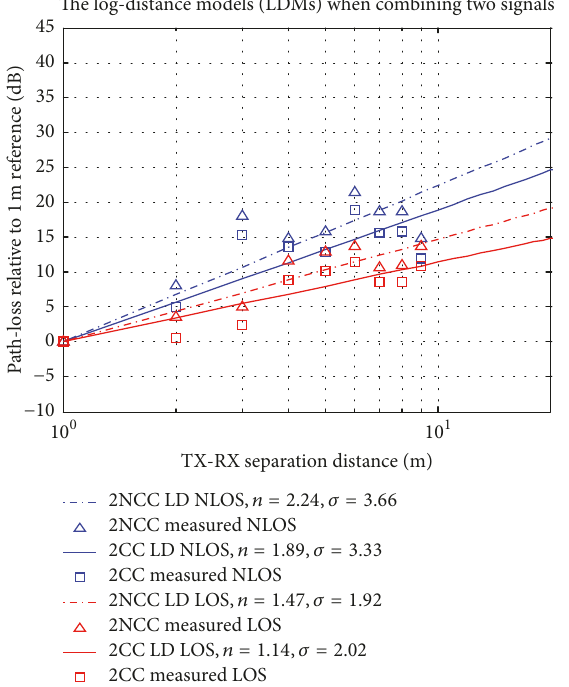
Figure 3: LDMs along with the measured scattered data when combining two signals coherently and noncoherently for the LOS and NLOS propagation scenarios.